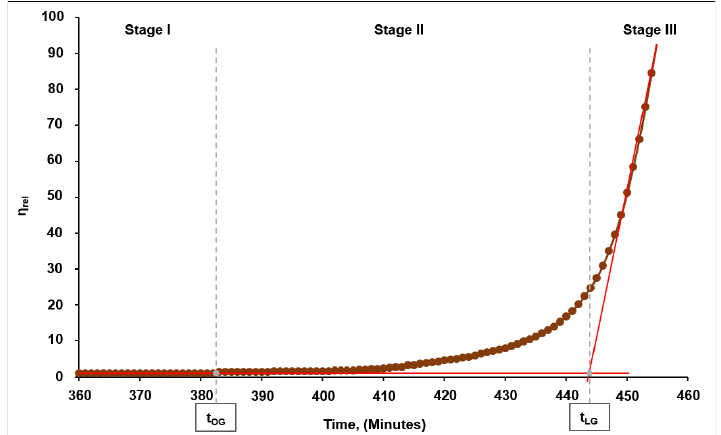
Figure 8. A typical rheokinetic curve of curing of the solution based on the azide copolymer, as exemplified by p-(GAT- co -GA)-14. exemplified by p-(GAT- co